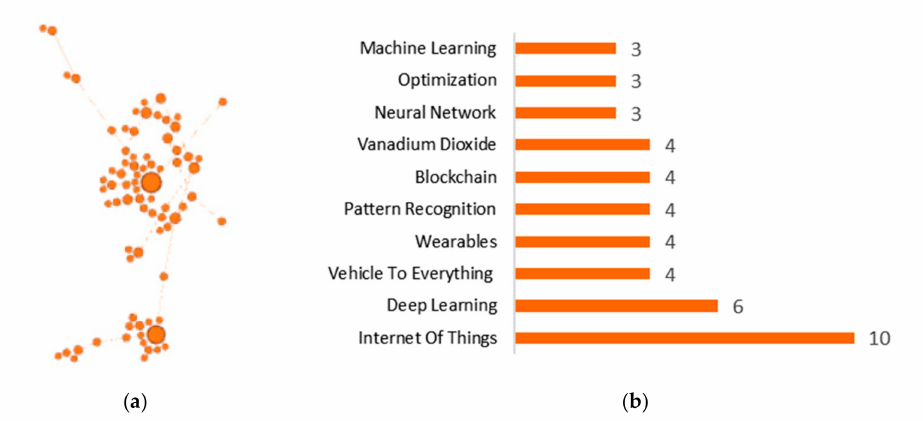
Figure 13. Representation of the Internet of Things community: ( a ) Isolated distribution of publications. ( b ) Keywords of the